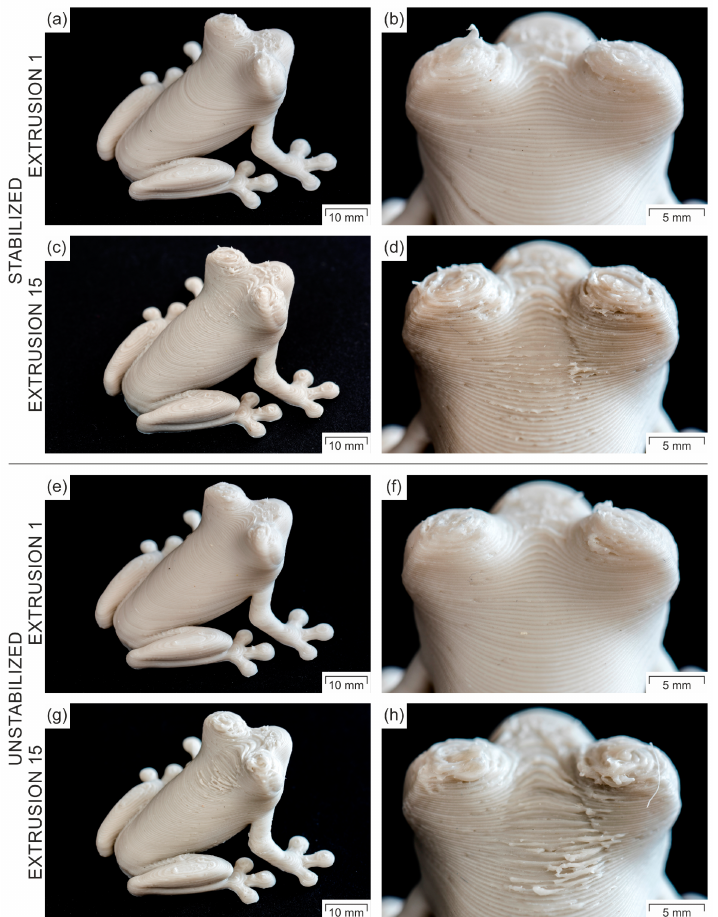
Figure 6. Comparison of the 3D-printing quality of a complex part with distinct overhangs, small details, and stairstep profiles for the two composites extruded 1 and 15